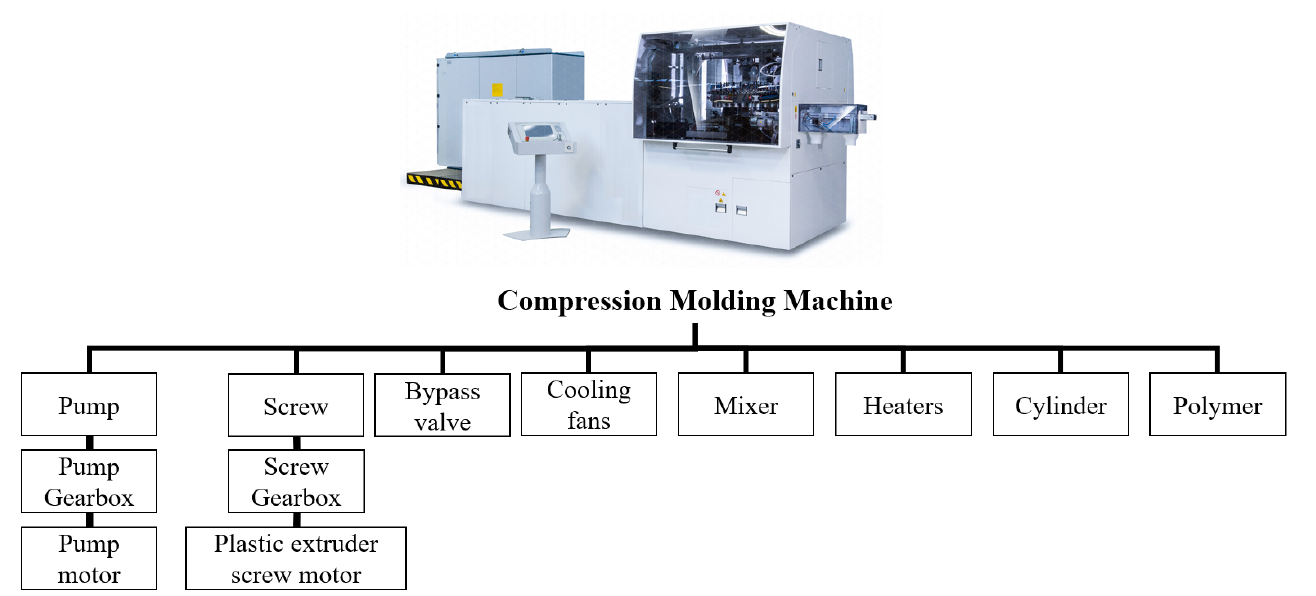
Figure 5. Structure of the compression molding machine.